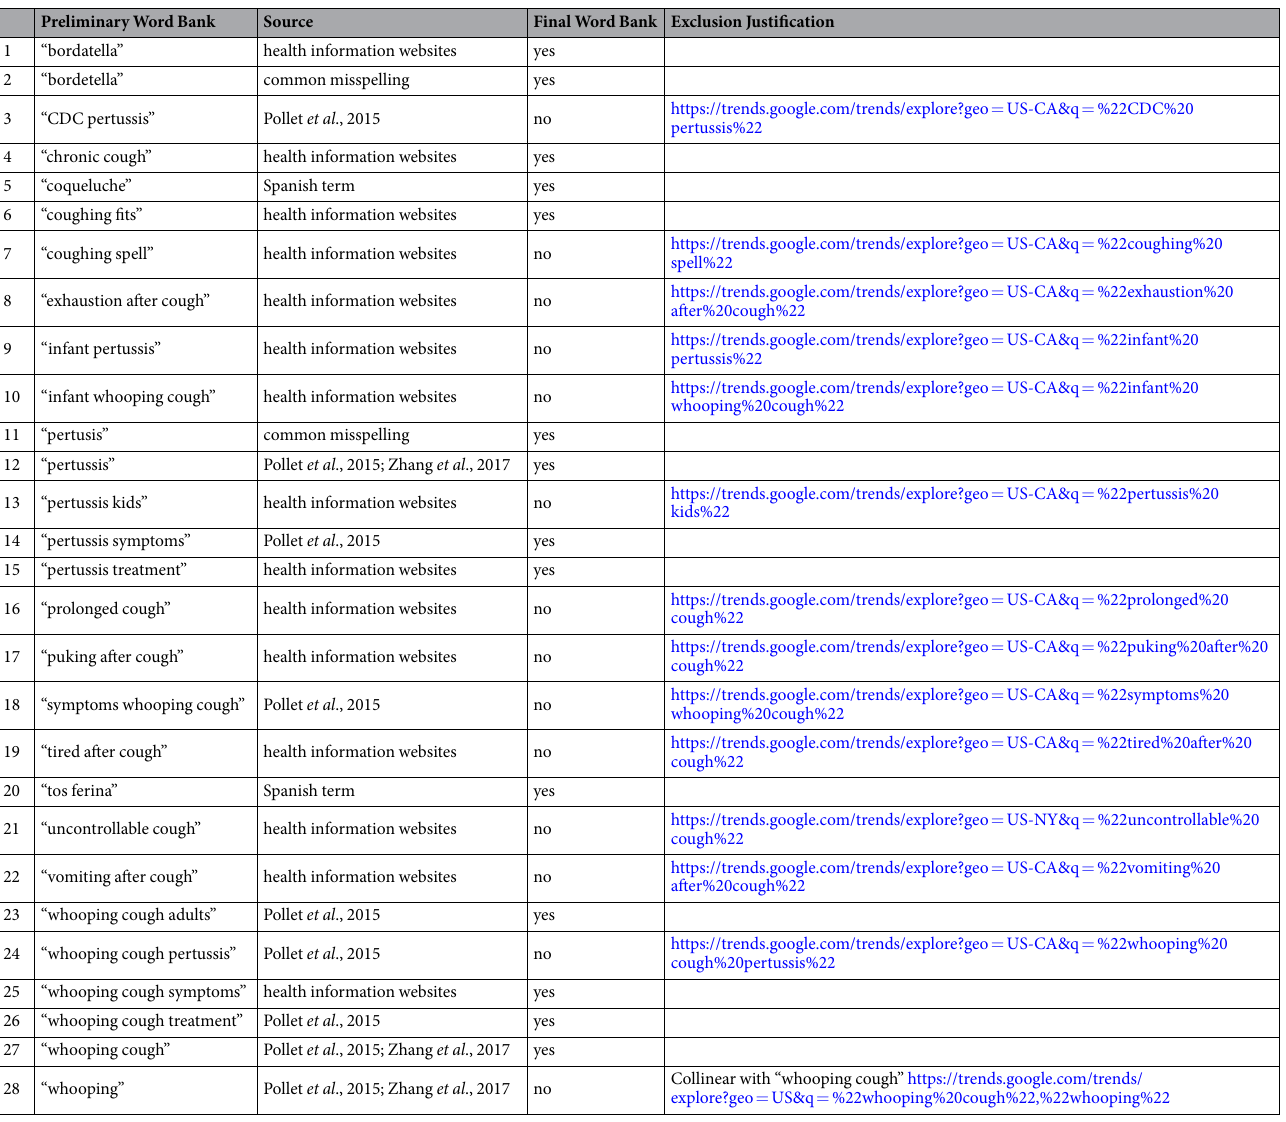
Table 1. Terms describing selection of the 14 GT searches used for modeling incidence. Specific GT links are provided to illustrate how many terms in the preliminary word bank were excluded because they failed to return nonzero results above the privacy threshold – even in the most populated states such as California and New